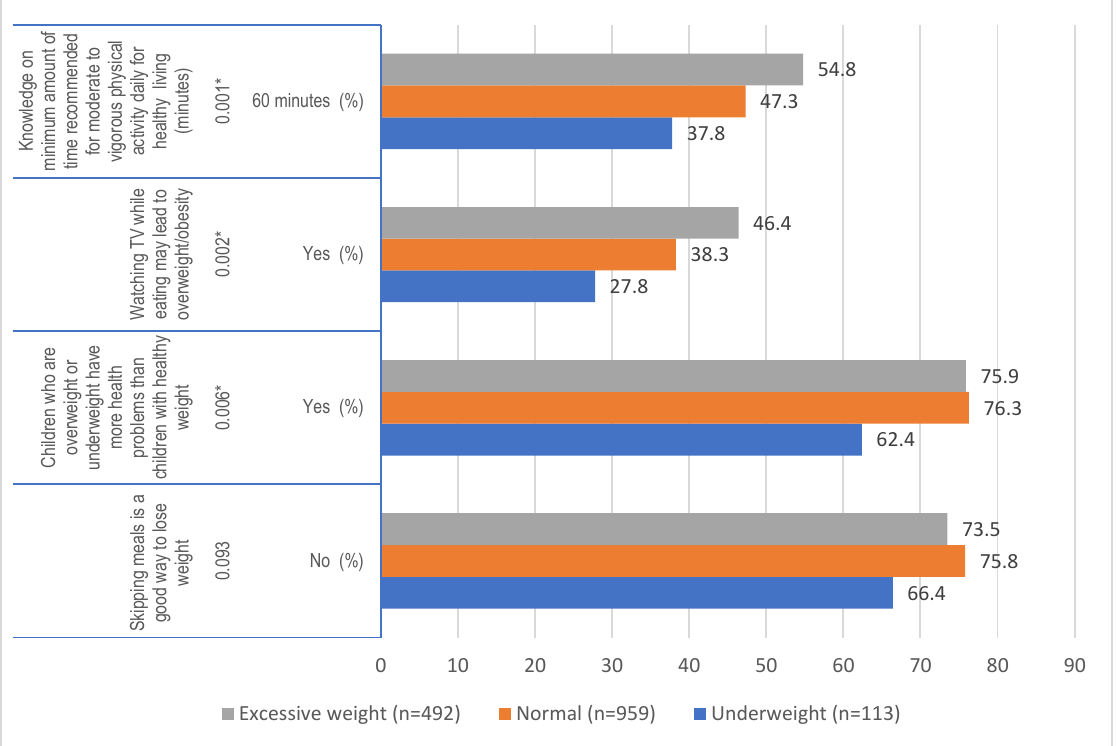
Figure 1. Univariate association of knowledge related to diet and physical activity and dietary behavior with BMI status of adolescence (* p values using Fisher’s Chi square *) * Correct responses are presented. Tukey’s post hoc test revealed that correct knowledge on the minimum amount of recommended moderate to vigorous physical activity was significantly lower in underweight vs. normal weight students ( p = 0.003) and significantly higher in excessive weight vs. underweight students ( p = 0.000); Correct knowledge on watching TV while eating may lead to overweight/obesity was significantly lower in normal vs. excessive weight students ( p = 0.01) and underweight vs. excessive weight ( p = 0.001); correct knowledge on health problems as a result of overweight was significantly lower for underweight vs. normal weight ( p = 0.004) and underweight vs. excessive weight (0.009). See also Supplementary Table S2. Table 2. Univariate associations of dietary and physical activity behaviors with BMI status of adolescents. Dietary Behaviours